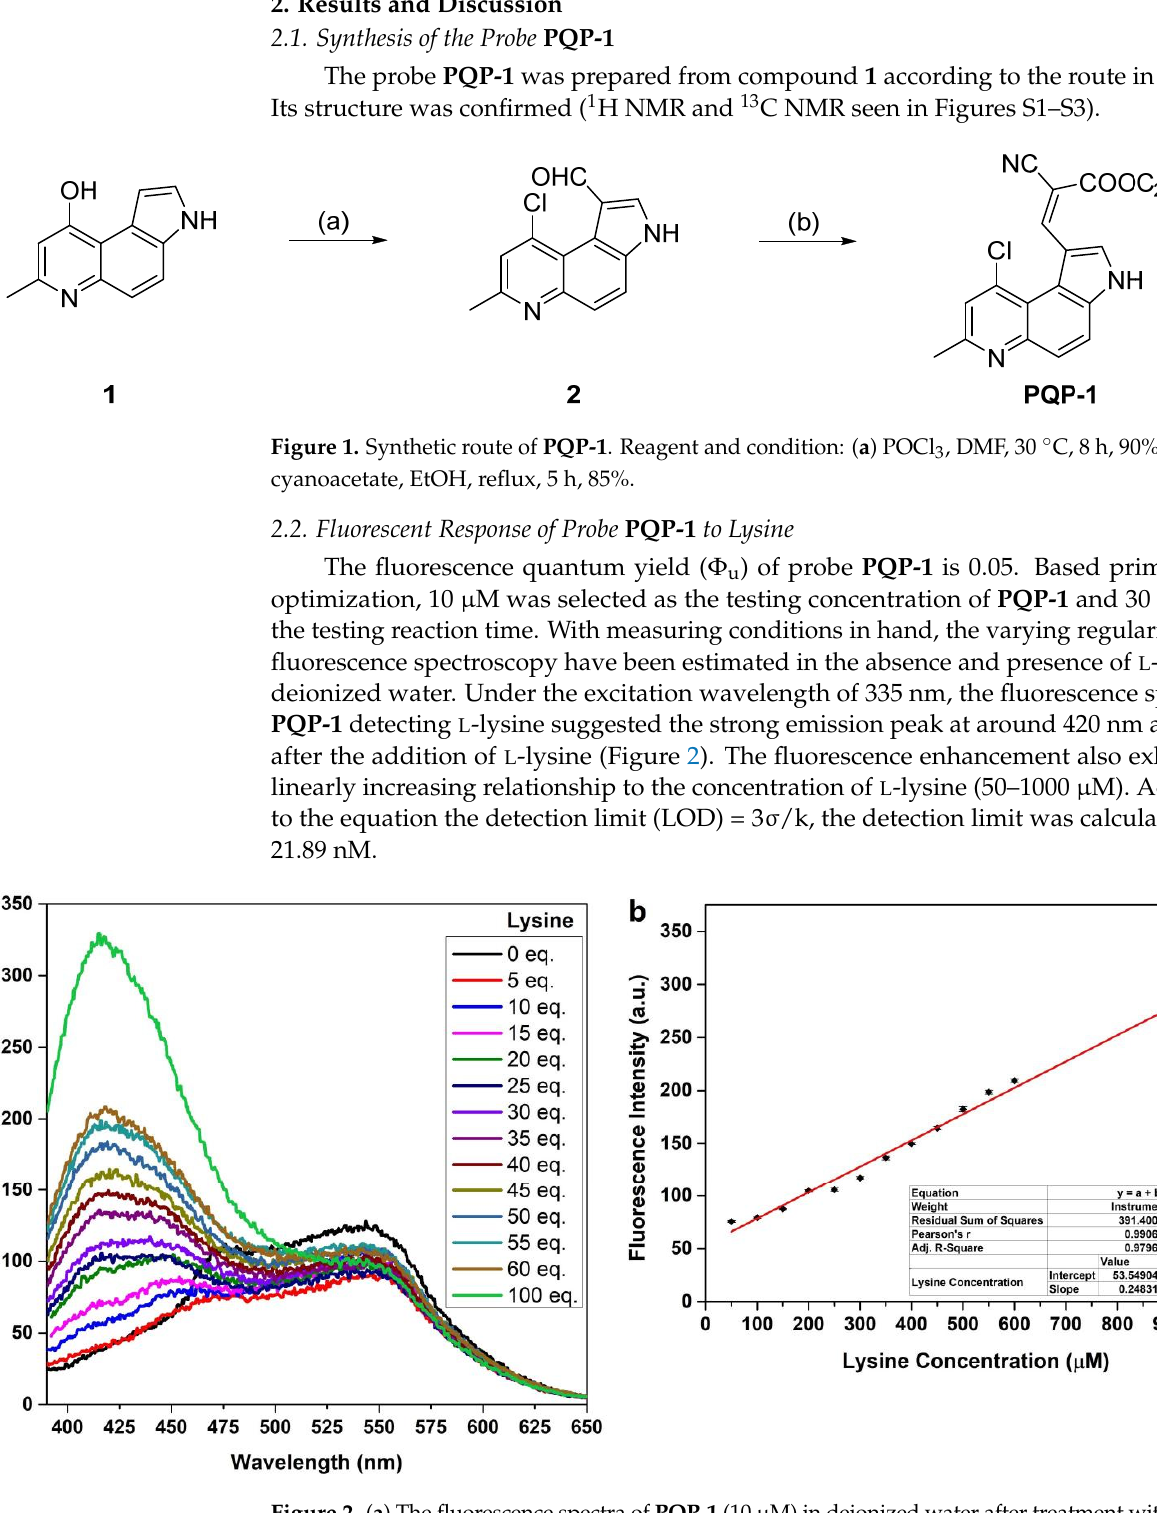
Figure 2. ( a ) The fluorescence spectra of PQP ‐ 1 (10 μ M) in deionized water after treatment with L ‐ lysine (0–1000 μ M) for 30 min; ( b ) The fluorescence intensity at around 420 nm has a good linear relationship with L ‐ lysine concentrations (50–1000 μ M). The data come from three parallel experiments.